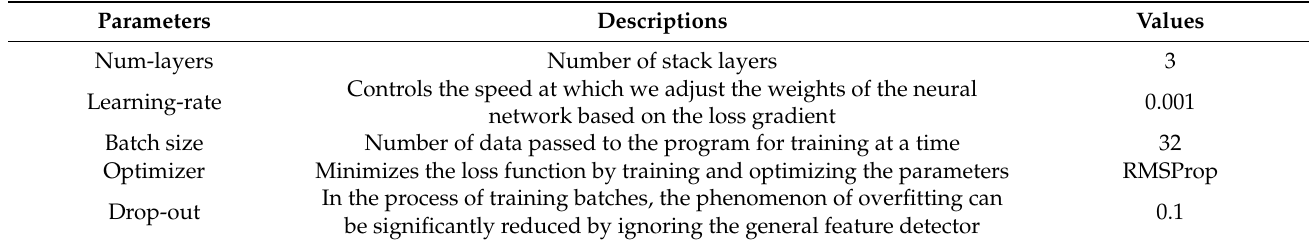
Table 2. Required parameters in Transformer.